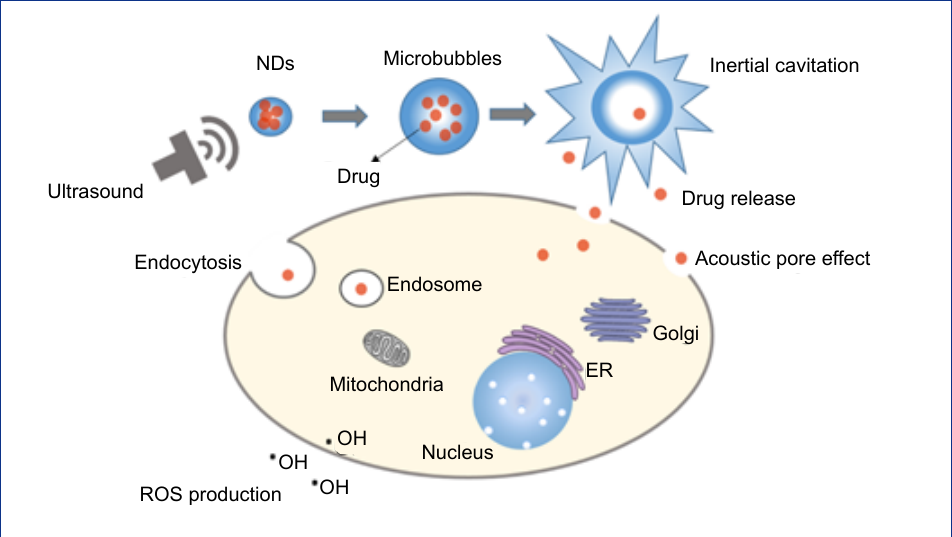
Figure 4 Schematic of drug delivery mediated by ultrasound-responsive